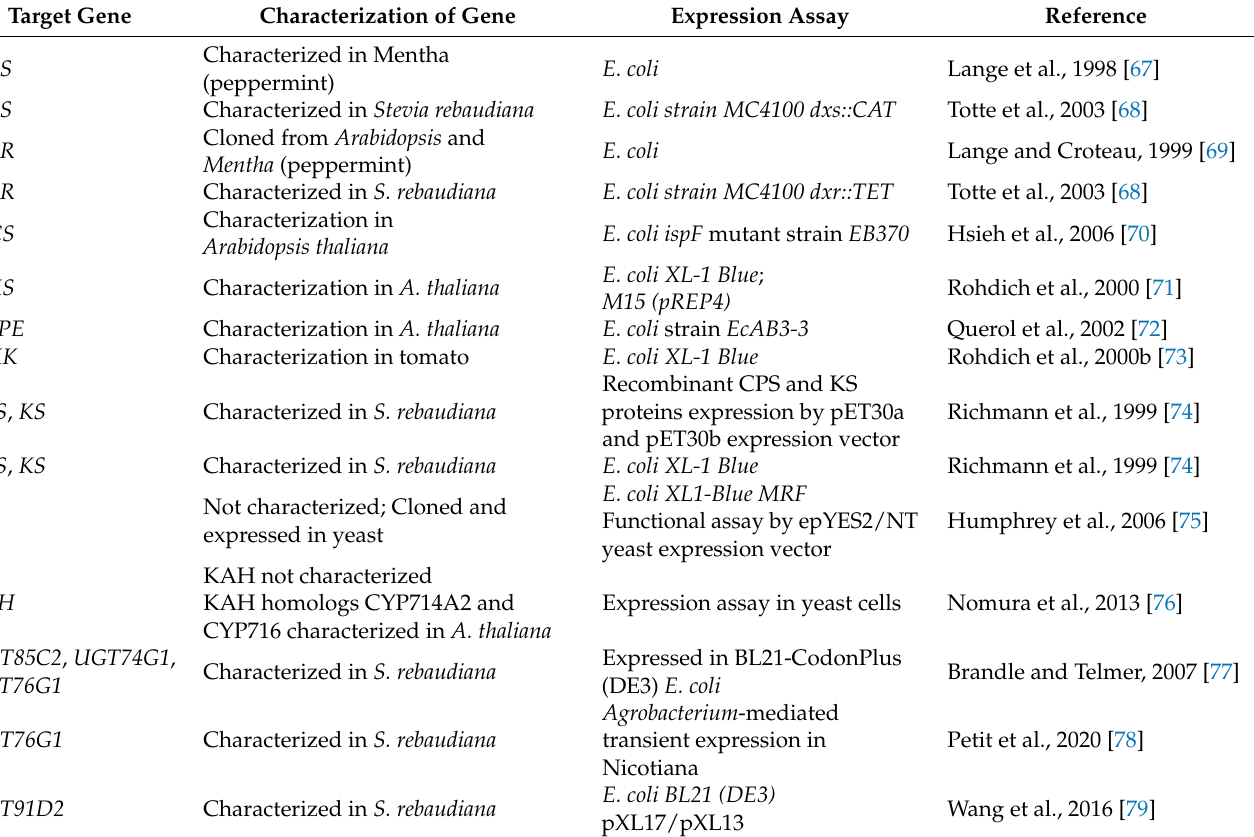
Table 3. Overview of the characterization and expression analysis of the genes involved in steviol glycosides biosynthesis